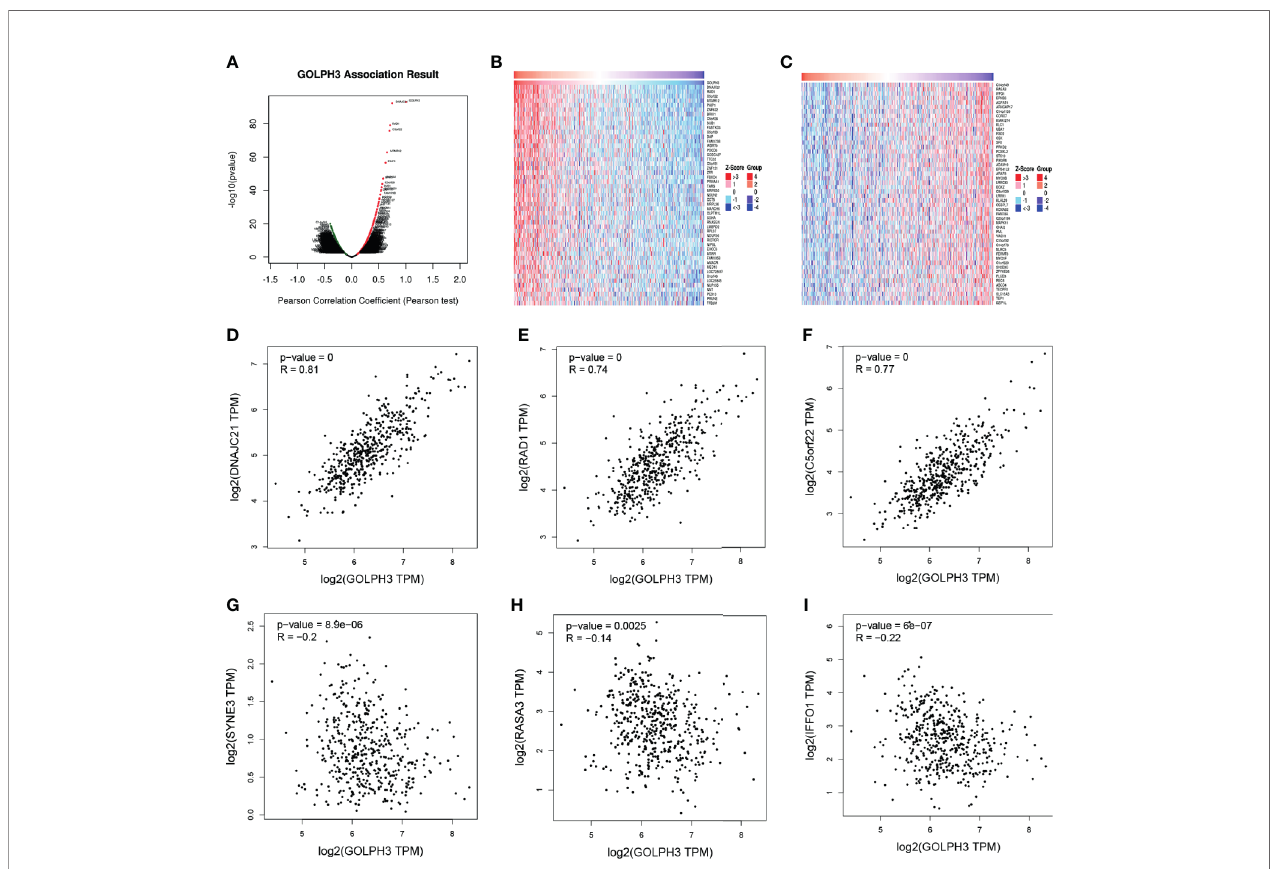
FIGURE 5 | GOLPH3 co-expression genes in LUAD (LinkedOmics and GEPIA). (A) The global genes highly correlated with GOLPH3 in LUAD were identi fi ed using Pearson ’ s test. (B, C) Heat maps show genes positively and negatively relevant to GOLPH3 (top 50). Red indicates positively correlated genes, and blue indicates negatively correlated genes. (D – F) Top 3 genes positively correlated with GOLPH3. (G – I) Top 3 genes negatively correlated with GOLPH3. LUAD, lung adenocarcinoma; GEPIA, Gene Expression Pro fi ling Interactive Analysis. All results are available